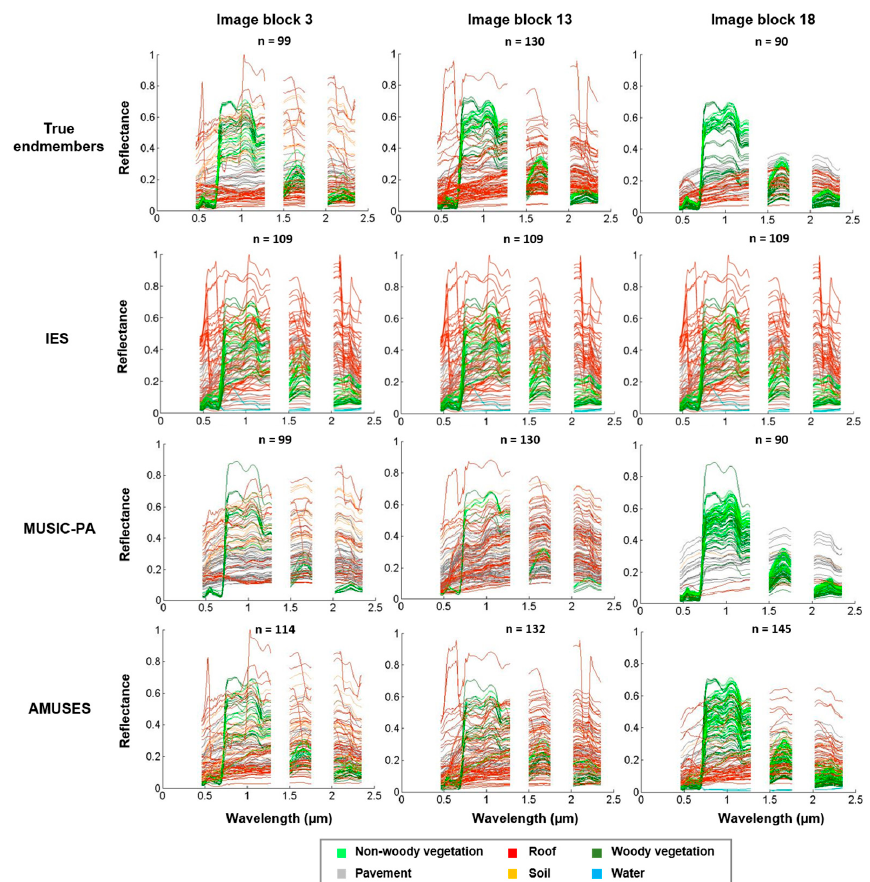
Figure 5. Comparison of true endmembers versus pruned libraries generated using IES, the original MUSIC-PA and the proposed AMUSES algorithm for image blocks 3, 13 and 18 (cf. Figure 2). The symbol “n” represents the size of the spectral library. The number of spectra to be retained by MUSIC-PA was manually set to match the true number of endmembers in the respective image blocks.